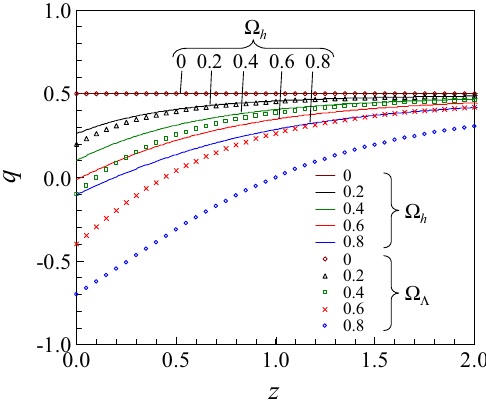
Fig. 2 Dependence of the luminosity distance d L on redshift z . The solid lines represent d L for the present model. The open diamonds with error bars are supernova data points taken from Refs. [3,4]. For the supernova data points, H 0 is set to 67 . 8 km/s/Mpc from the Planck